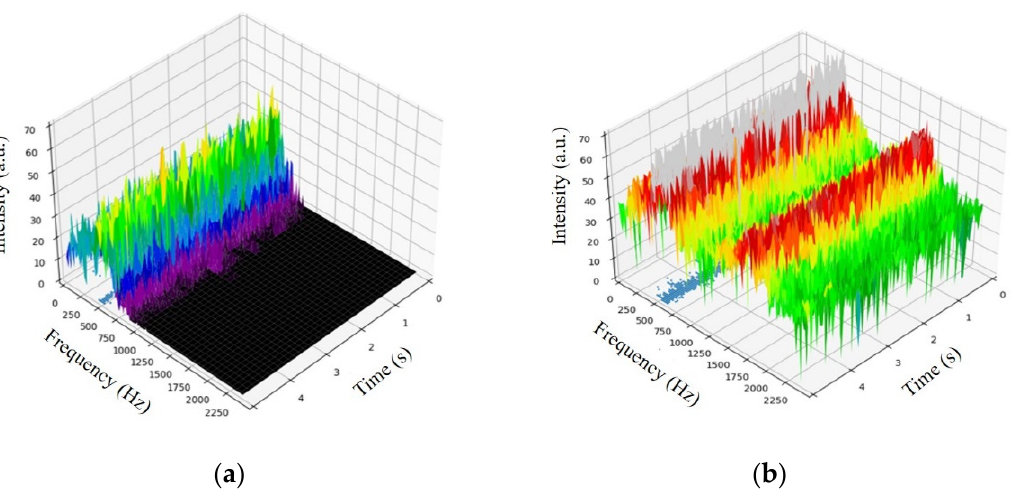
Figure 3. Time-spectrum data graphs obtained by MFCC speech recognition: ( a ) ambient sound and ( b ) PVC pipe leakage.